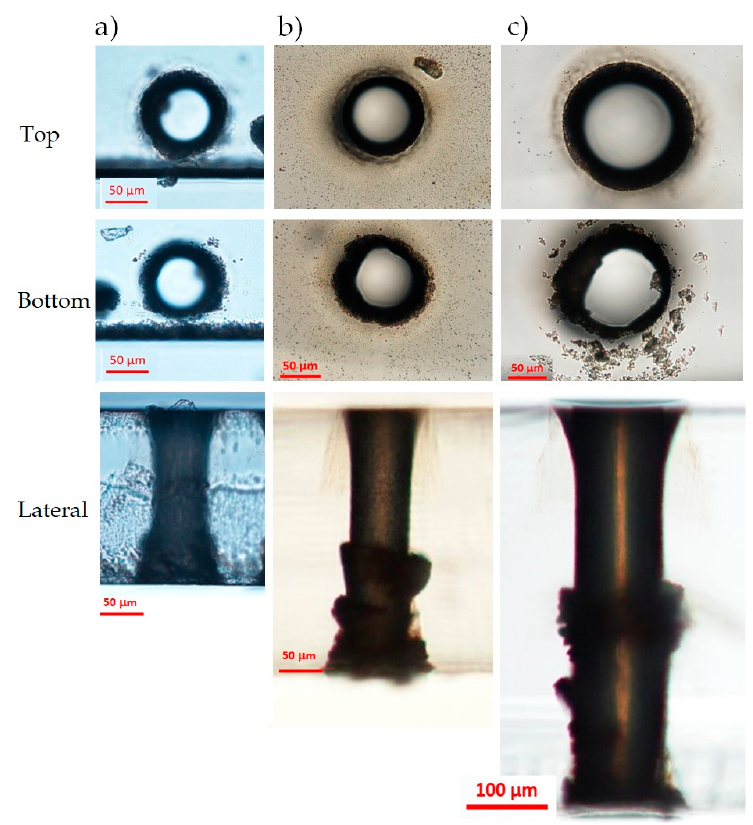
Figure 5. Optical microscope images (taken after an ultrasonic bath in acetone) of holes (top surfaces (first row), bottom surfaces (second row), lateral views (third row)) generated with the BB drilling technique in three different glass samples. ( a ) 200 μ m thick AF32 glass (130 μ J pulse energy, 50 writing circles, one machining pass); ( b ) 300 μ m thick D263 glass (300 μ J pulse energy, 55 writing circles, two machining passes); ( c ) 500 μ m thick Eagle XG glass (390 μ J pulse energy, 100 writing circles, three machining passes).